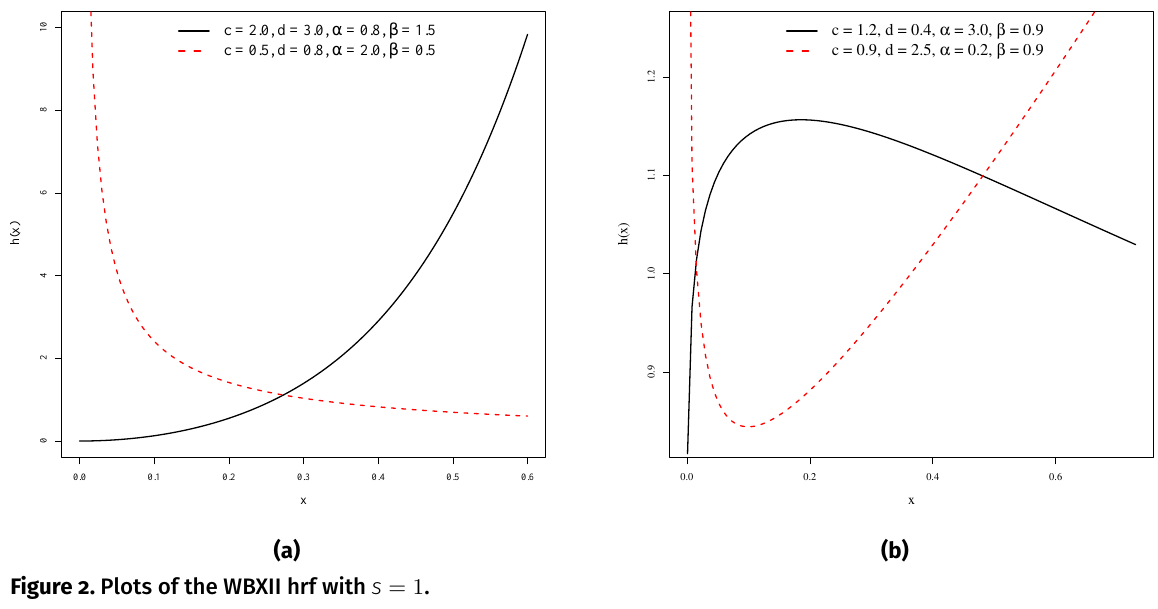
Figure 2. Plots of the WBXII hrf with s = 1